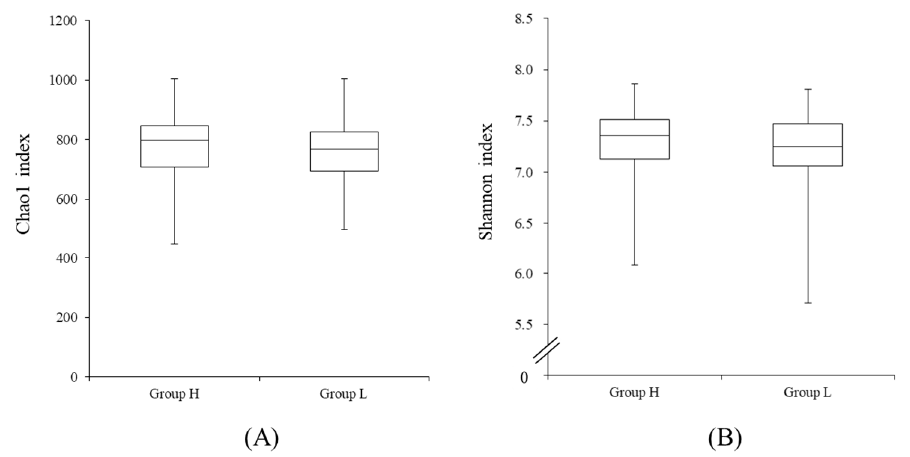
Figure 1. Chao1 ( A ) and Shannon ( B ) indices of the fecal microbiotas in high- and low-reproductive performance groups. Panel A: Chao1 index; Panel B: Shannon index.